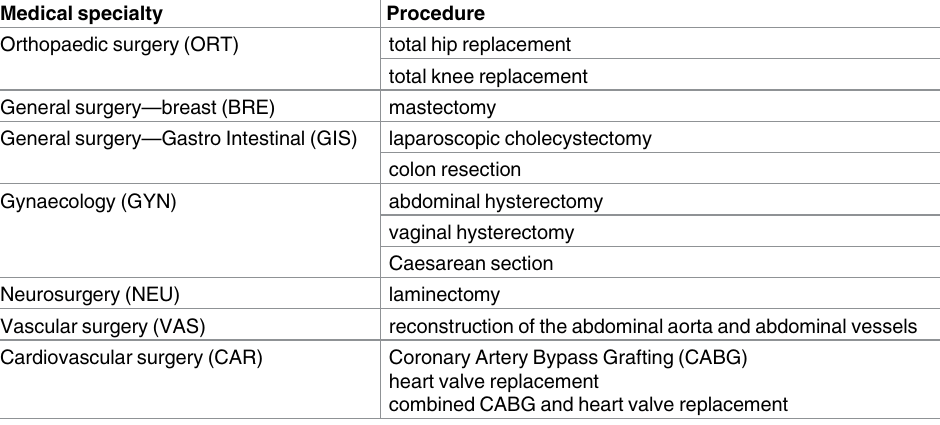
Table 2. Index surgeries: Thirteen surgical procedures selectedby the DHPSP.